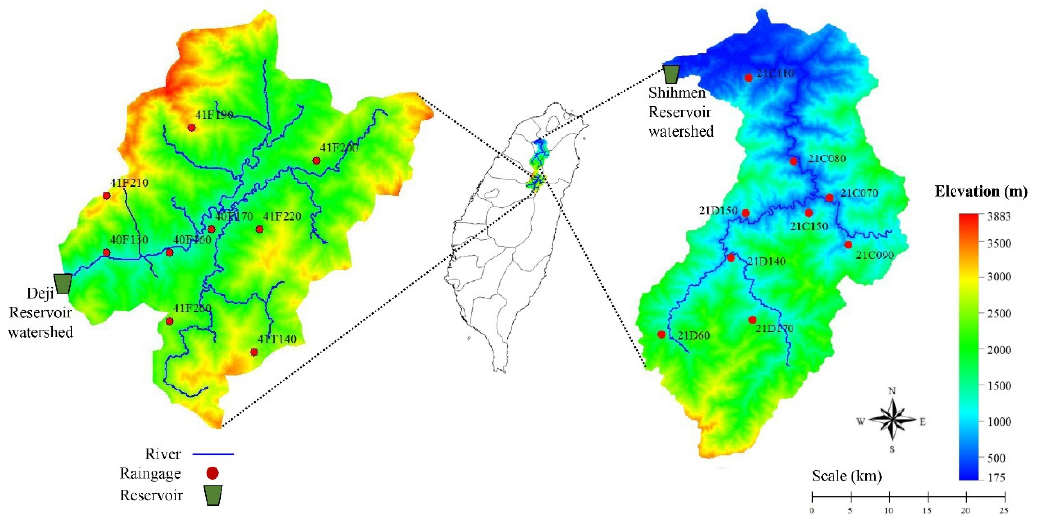
Figure 1. Deji and Shihmen Reservoir watersheds. Table 1. Geographic information on the rain gages in the Deji Reservoir watersheds.